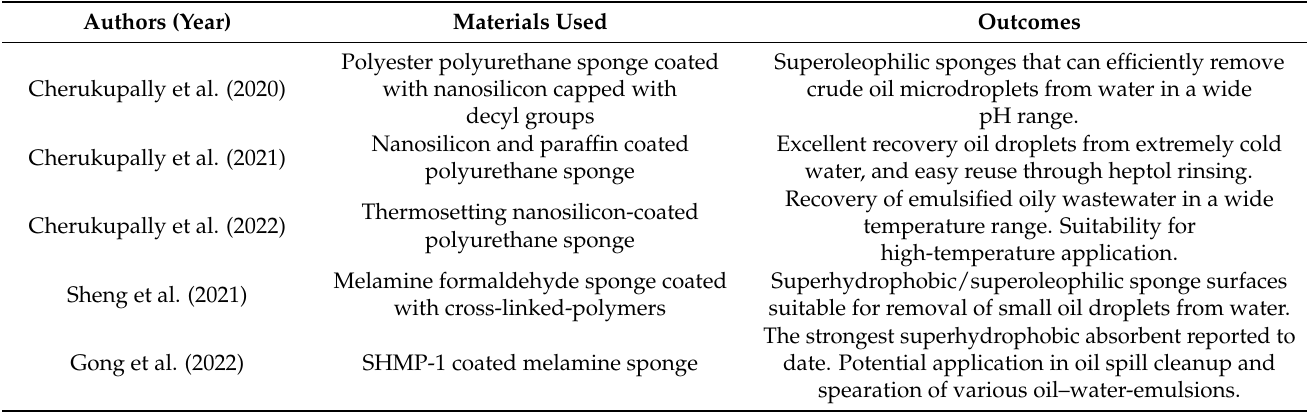
Table 13. Recent studies on surface modifications of polymer sponges with functional materials for wastewater